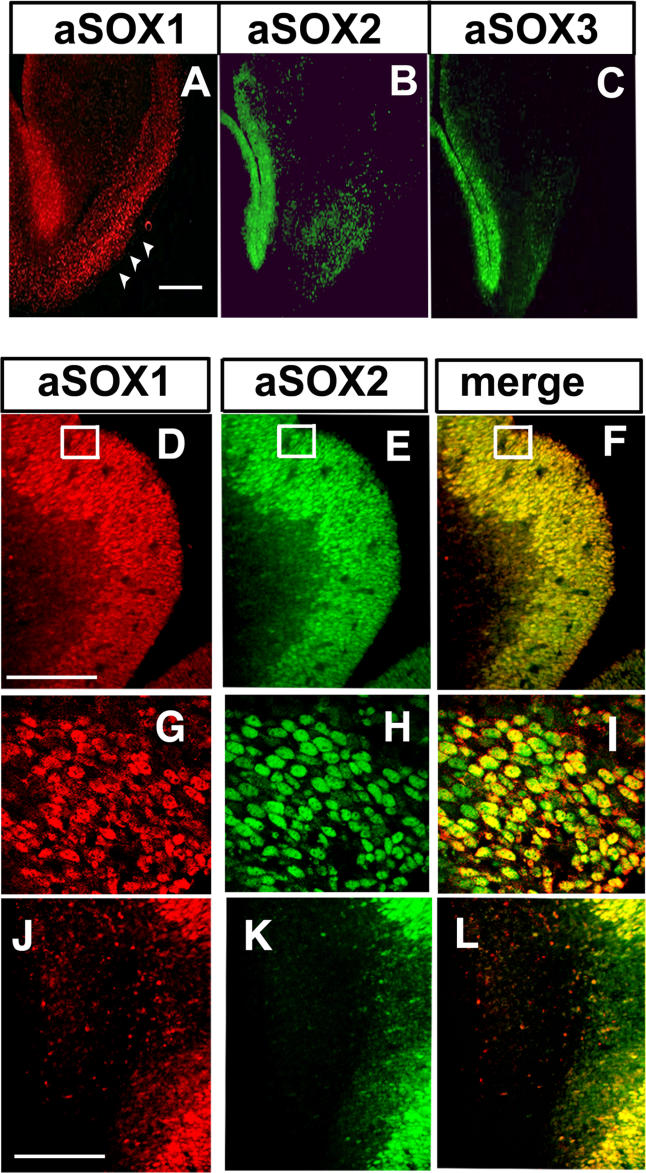
SOX2 and SOX3 Down-Regulation in LGE Neurons and SOX1/SOX2 Co-Expression in LGE PrecursorsImmunofluorescence of coronal sections at LGE levels in (A–C) E15- and (D–L) E13-stage wild-type embryos visualized on a confocal microscope: antibody staining for (A, D, G, and J) SOX1 (red), (B, E, H, and K) SOX2 (green), (C) SOX3 (green), (D–L) double SOX1 (red) and SOX2 (green), and (F, I, and L) merged. In the OT area and the LGE mantle, there are more neurons expressing SOX1 (A and J) than SOX2 (B and K) and SOX3 (C). Note the extensive co-expression of the SOX1 and SOX2 in precursors (D–I). (G–I) are higher magnifications of the areas within the rectangles. Scale bar = 300 μm.